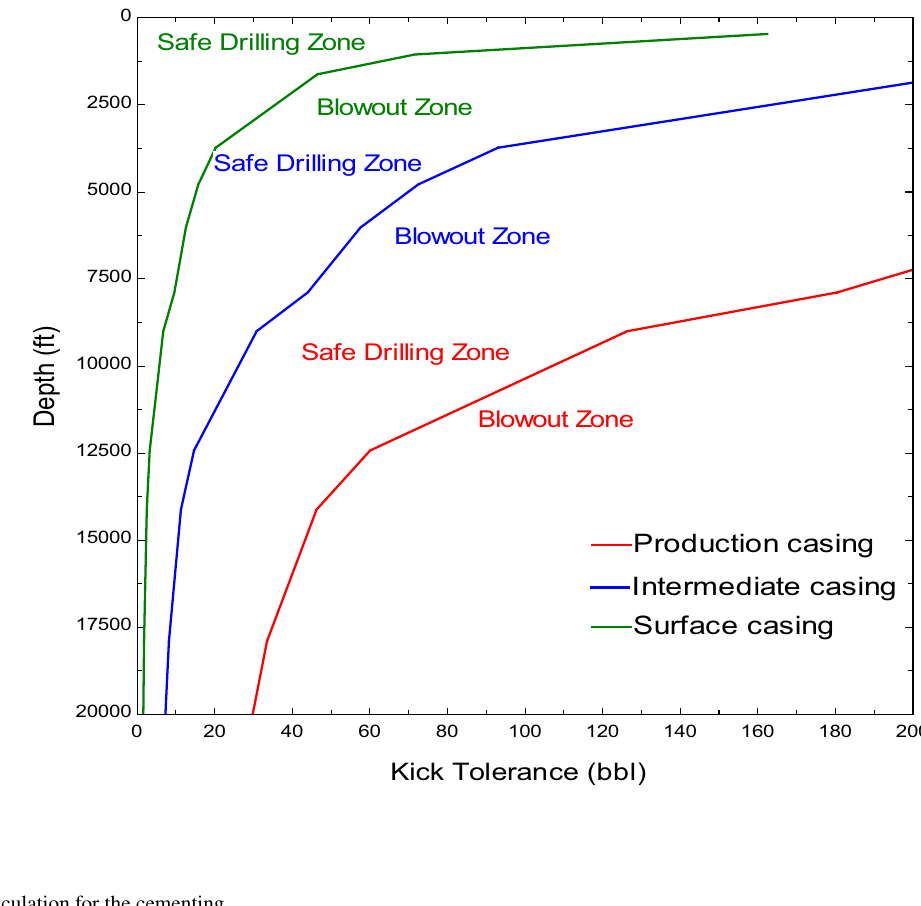
Fig. 20 Kick tolerance (bbl) versus depth (m) on the top of Tulamura